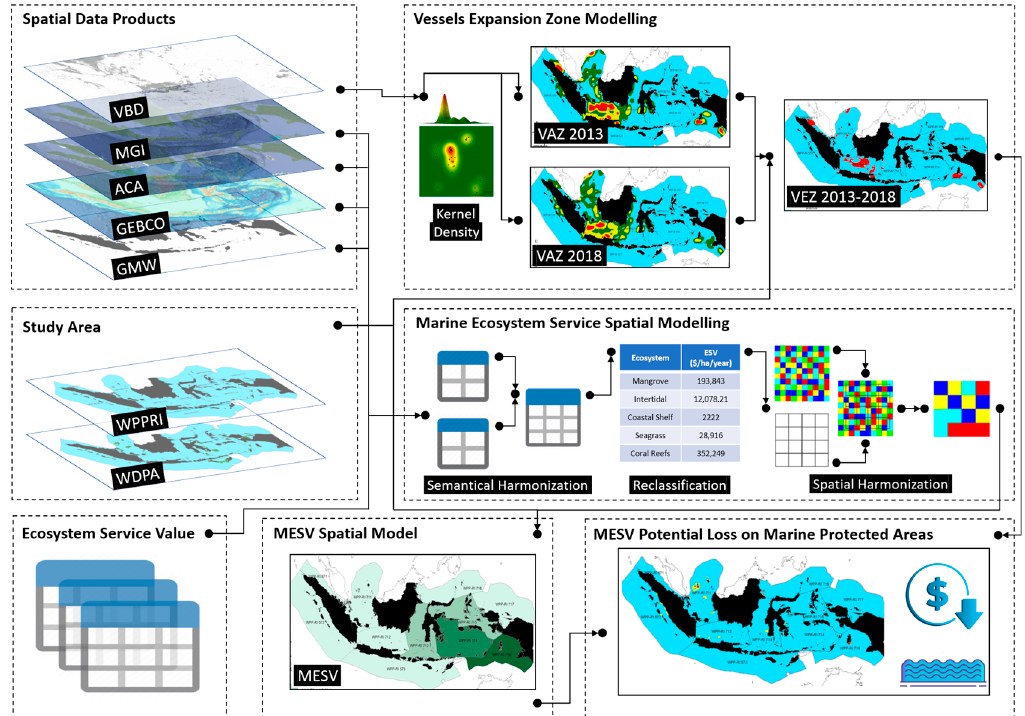
Figure 2. Schematic depicting the research framework developed in this study.